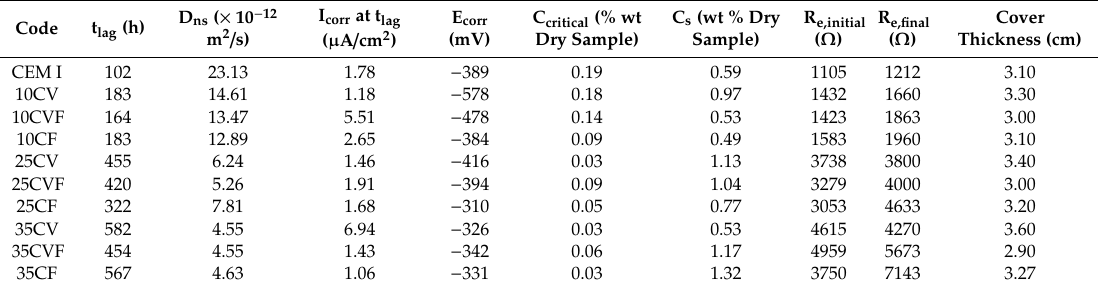
Table 3. Recorded for each mortar mix 1